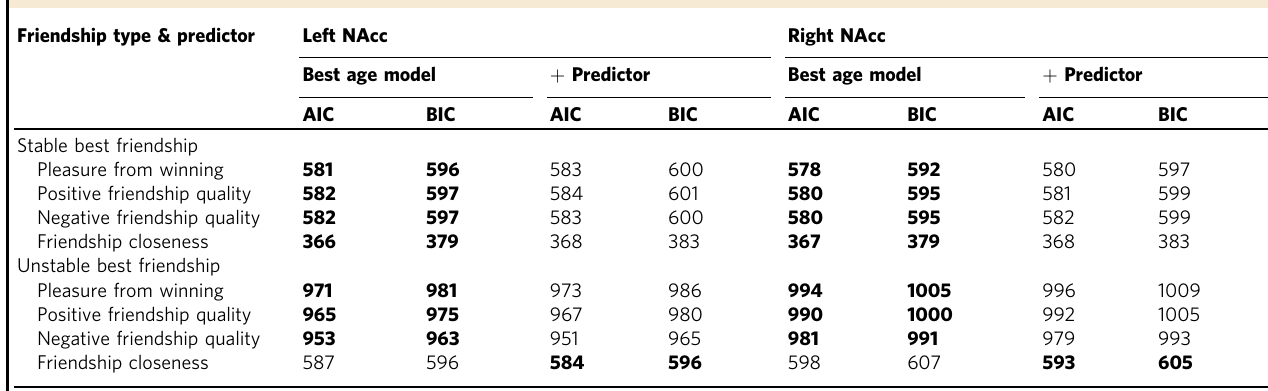
Table 3 AIC and BIC values for the models to describe relations between NAcc and the pleasure ratings, and friendship quality and closeness.